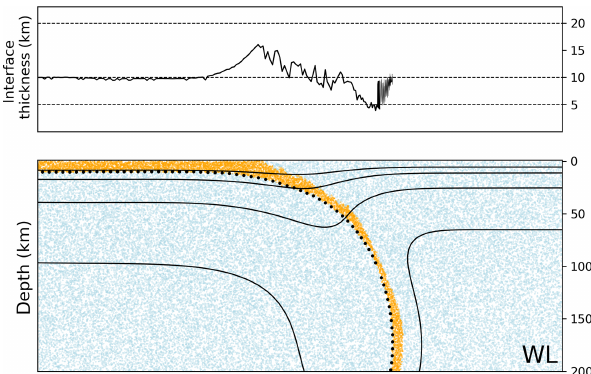
Figure 12. Interface thickness in under-resolved WL model. In the lower panel orange points show the subduction interface material, and blue points are the background material (mantle/lithosphere). The upper panel shows interface thickness. This figure shows the model state 10Myr after model initiation. This model is also shown in the upper left panel of Fig. 11a.